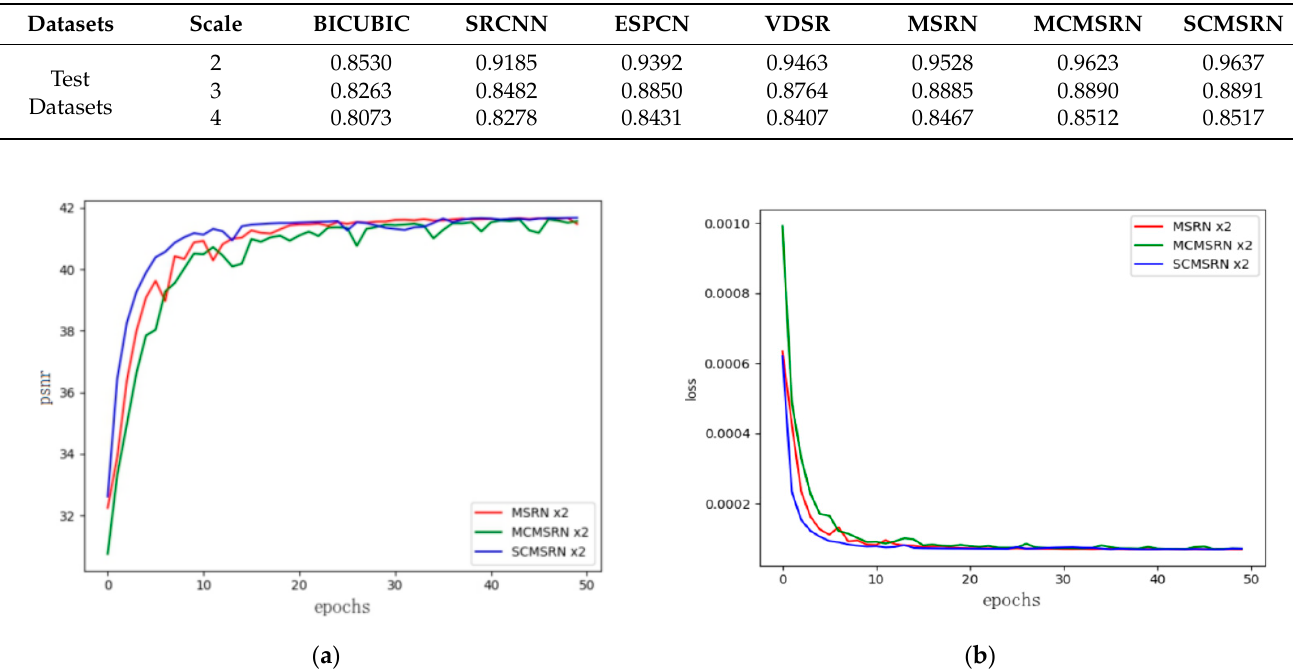
Figure 5. Model convergence analysis diagram x2. ( a ) PSNR-epochs curve; ( b ) loss-epochs curve.